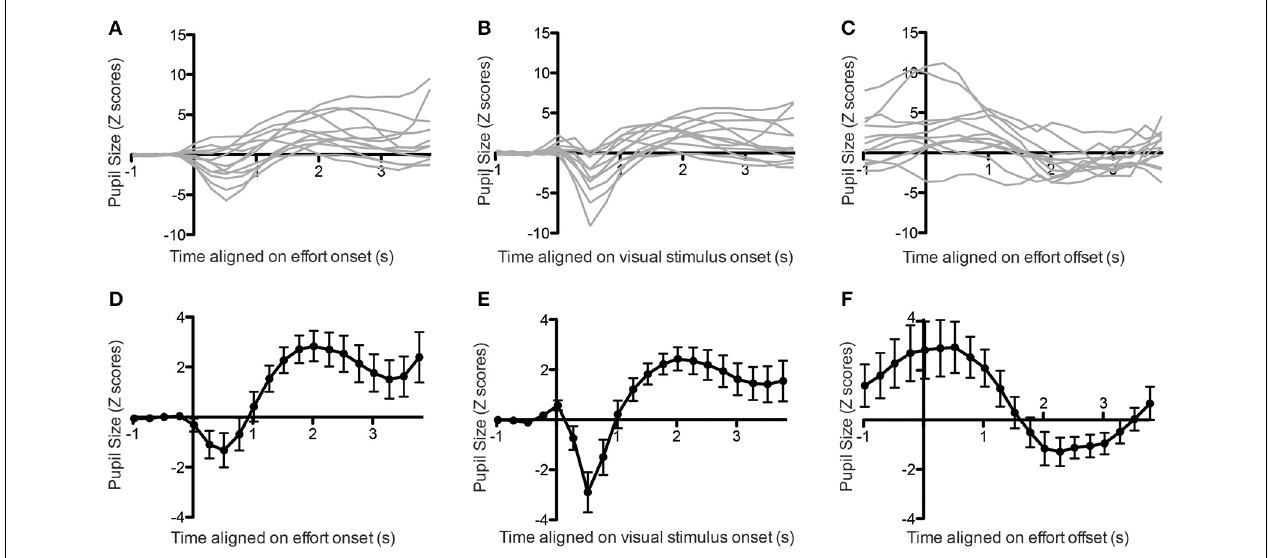
FIGURE 2 | Pupil size aligned on effort onset (A, individual subjects, D, average), stimulus onset (B, individual subjects, E, average) or effort offset (C, individual subjects, F, average). Error bars indicate standard error of the mean.